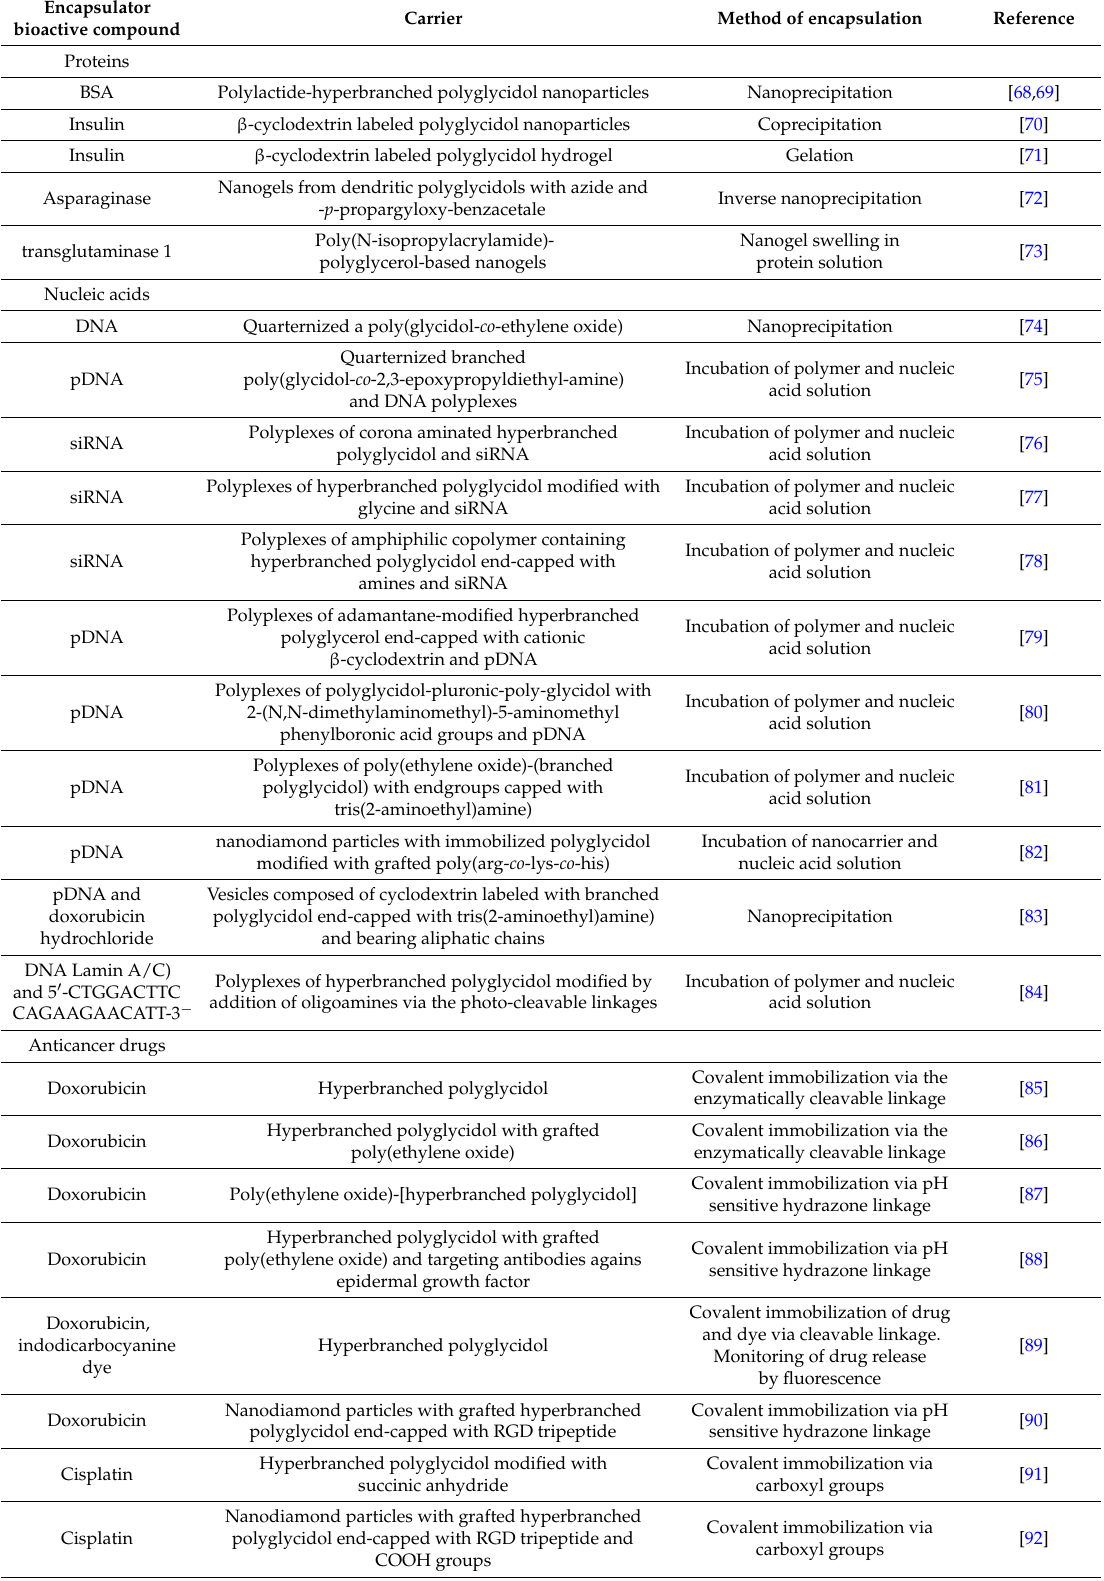
Table 1. Drug carriers based on polyglycidol and polyglycidol